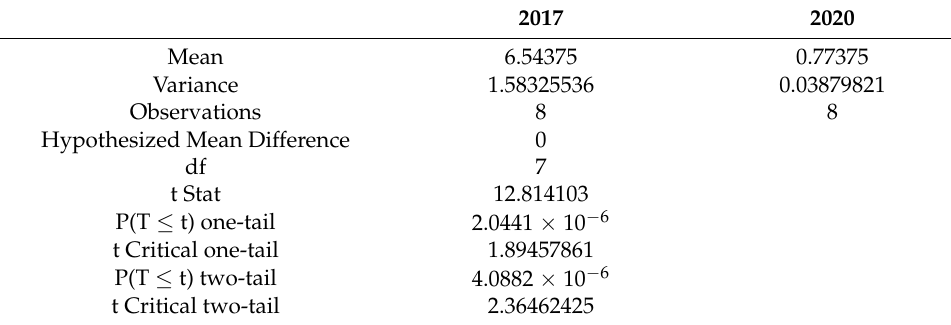
Table 3. t -Test: Two-Sample Assuming Unequal Variances.